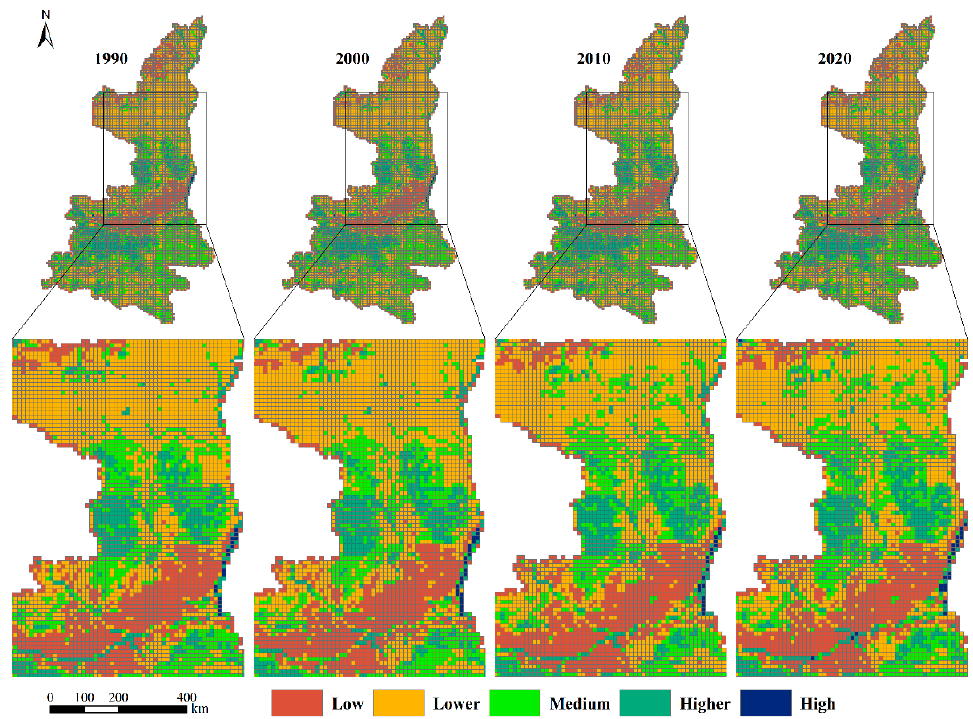
Figure 4. Spatial distribution patterns of ESVs in Shaanxi Province from 1990 to 2020.